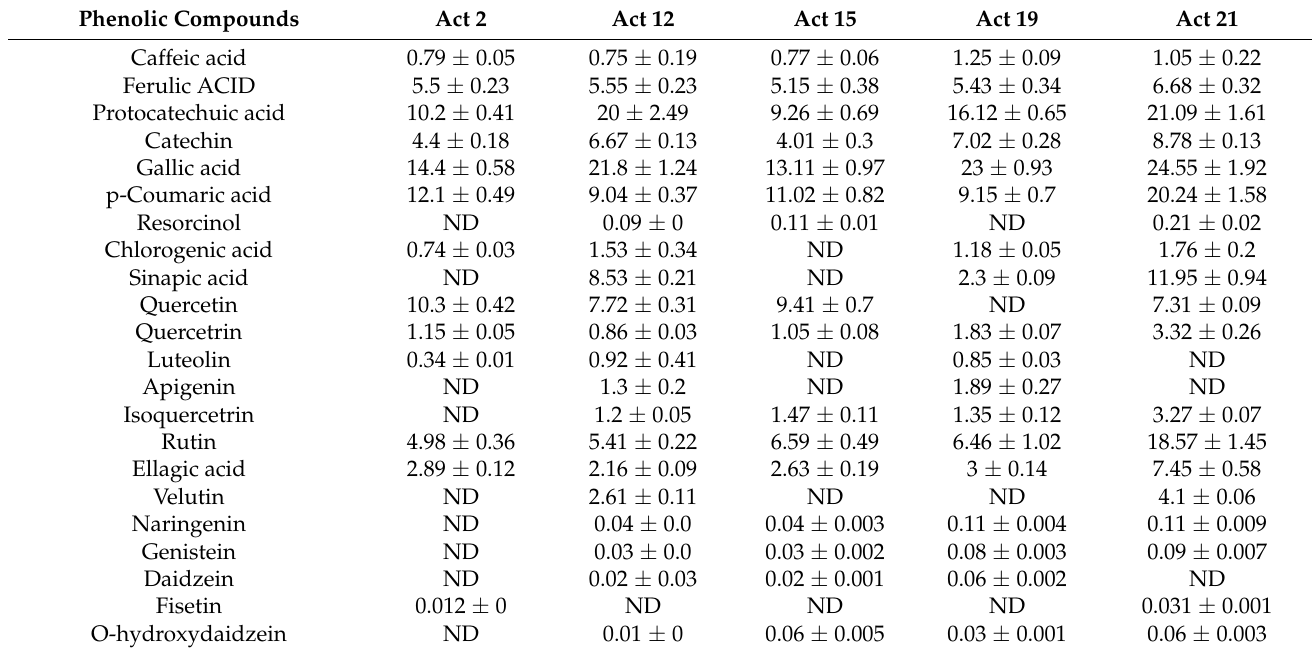
Table 5. The phenolic profile of five most biologically active Streptomyces isolates (Act 2, Act 12, Act 15, Act 19 and Act 21). Data are represented by the means of at least 3 replicates and error bars represent standard